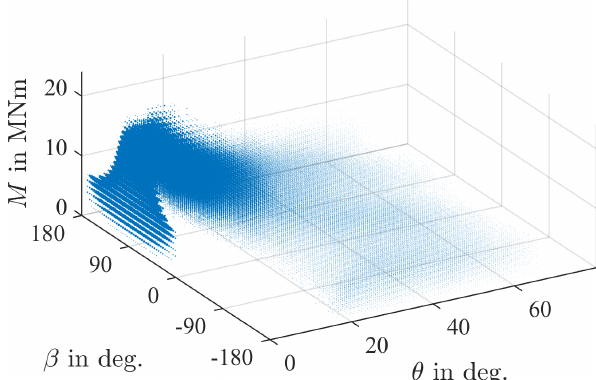
Figure 7. Forces Q j for a contact j at 0 ◦ for a fixed moment of M = 10MNm.